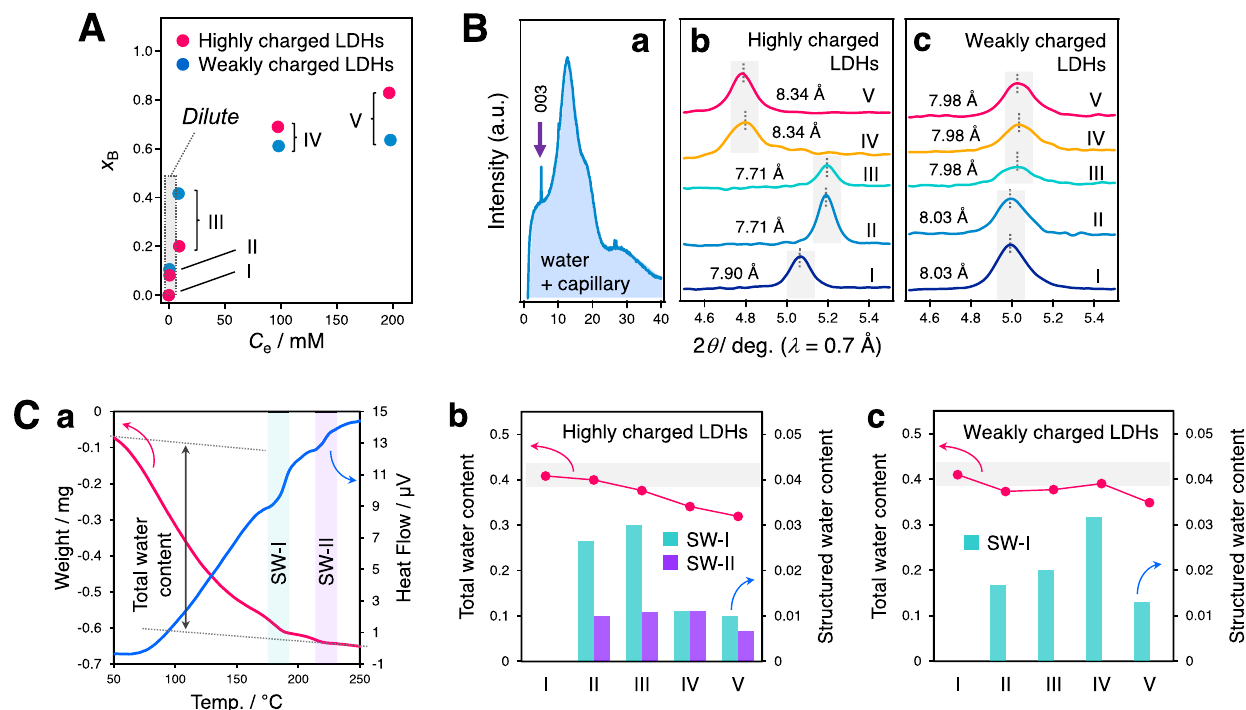
Fig.4|Exsituanalysisofthechangesintheinterlayerdistanceandthecontent of interlayer water in nitrate ion storage. A Ion-exchange adsorption isotherms fornitrateintheconcentratedregionwithrespecttothehighlyandweaklycharged LDHs, corresponding to Fig.2c after the Y axis is modi fi ed to the corresponding x B value. B The representative exsitusynchrotronpowderXRDpatterns of the highly charged LDHs (II in A ) ( a ) and closer inspection of the wet-XRD patterns of the